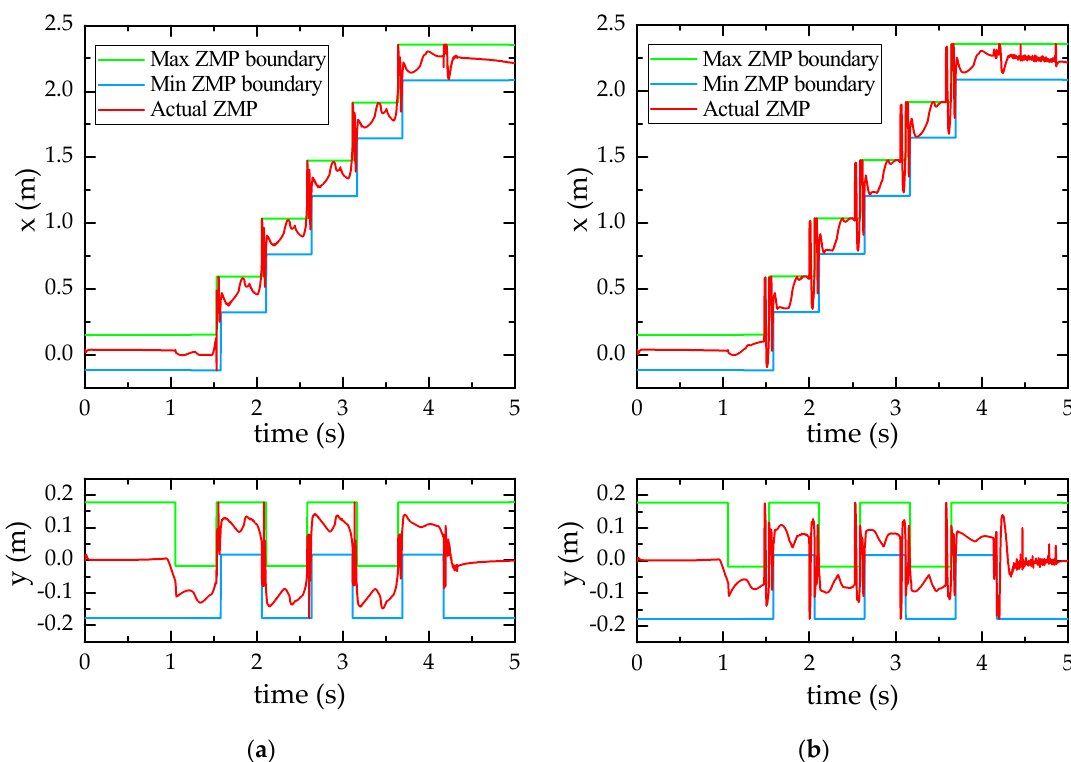
Figure 5. ZMP trajectory. The actual ZMP is calculated based on the data measured by the six-dimensional F-T sensor. The ZMP boundary is the boundary of the sole of the support leg. ( a ) Case 1; ( b ) Case 2. The ZMP trajectories are nearer to the boundaries in Case 2 than in Case 1. Appl. Sci. 2019 , 9 , x Secondly, we have compared the moments required to walk as planned in Case 1 and Case 3.